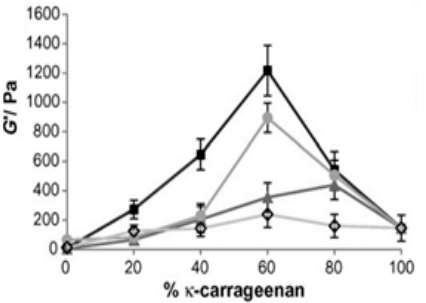
Figure 4. G’ elastic component of galactomannan/ -carrageenan mixed gels (guar gum ; locust bean gum ( ■ ); Gleditsia triacanthos galactomannan ( ♢ ) and Sophora japonica galactomannan ( ))